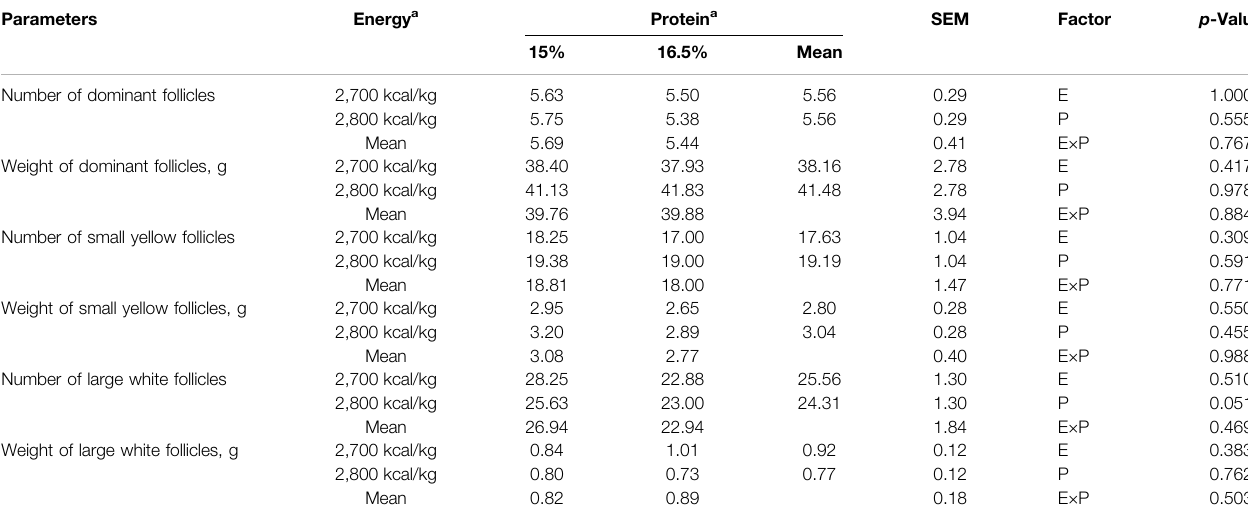
TABLE 6 | Effect of dietary metabolizable energy (E) and crude protein (P) levels during the prelay period (15 – 20 weeks of age) on ovarian parameters of laying hens at 72 week of age.